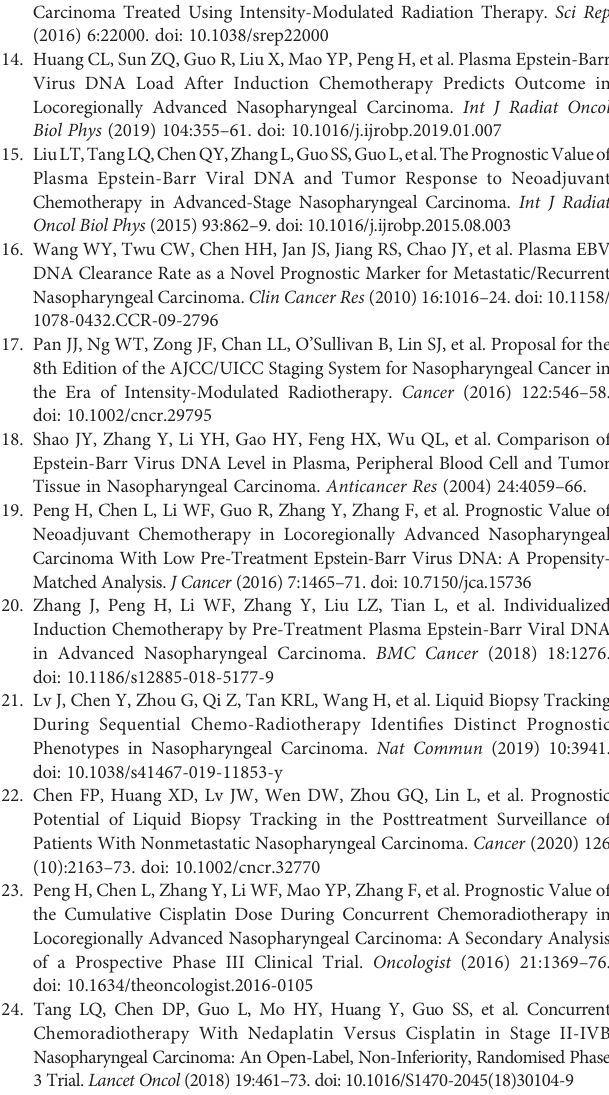
Supplementary Figure 6 | Kaplan-Meier survival curves of (A) overall survival, (B) disease-free survival, (C) distant failure-free survival and (D) locoregional failure- free survival between different risk groups of RPA2 staging. Supplementary Figure 7 | Time-independent OS, DFS, DFFS and LRRFS ROCs of different staging in boostrap analysis. ROC, receiver operating curve; AUC, area under curve; OS, overall survival; DFS, disease-free survival; DFFS, distant failure- free survival; LRRFS, locoregional relapse-free survival.